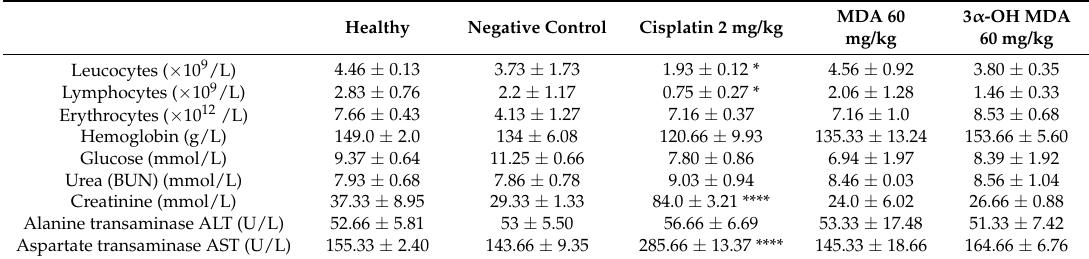
Table 3. Evaluation of preclinical systemic toxicities of MDA and 3 α -OH MDA in the blood after treatment. The values of biochemical parameters are reported as the means ±